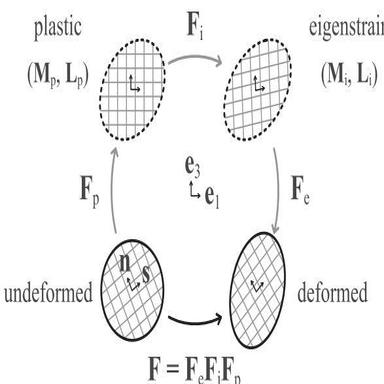
Illustration of the intermediate configurations resulting from the multiplicative decomposition of the deformation gradient. Selecting the crystal orientation as initial value of F O p( 0) t = = 0 guarantees that the lattice coordinate system in the plastic configuration always coincides with the lab coordinate system.